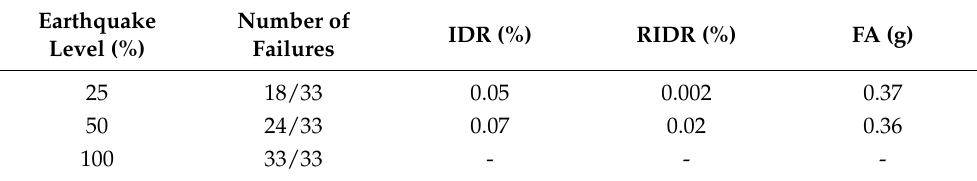
Table 4. Number of failures and peak IDR, RDIR, FA values-case (i): flexural and shear hinges. Earthquake